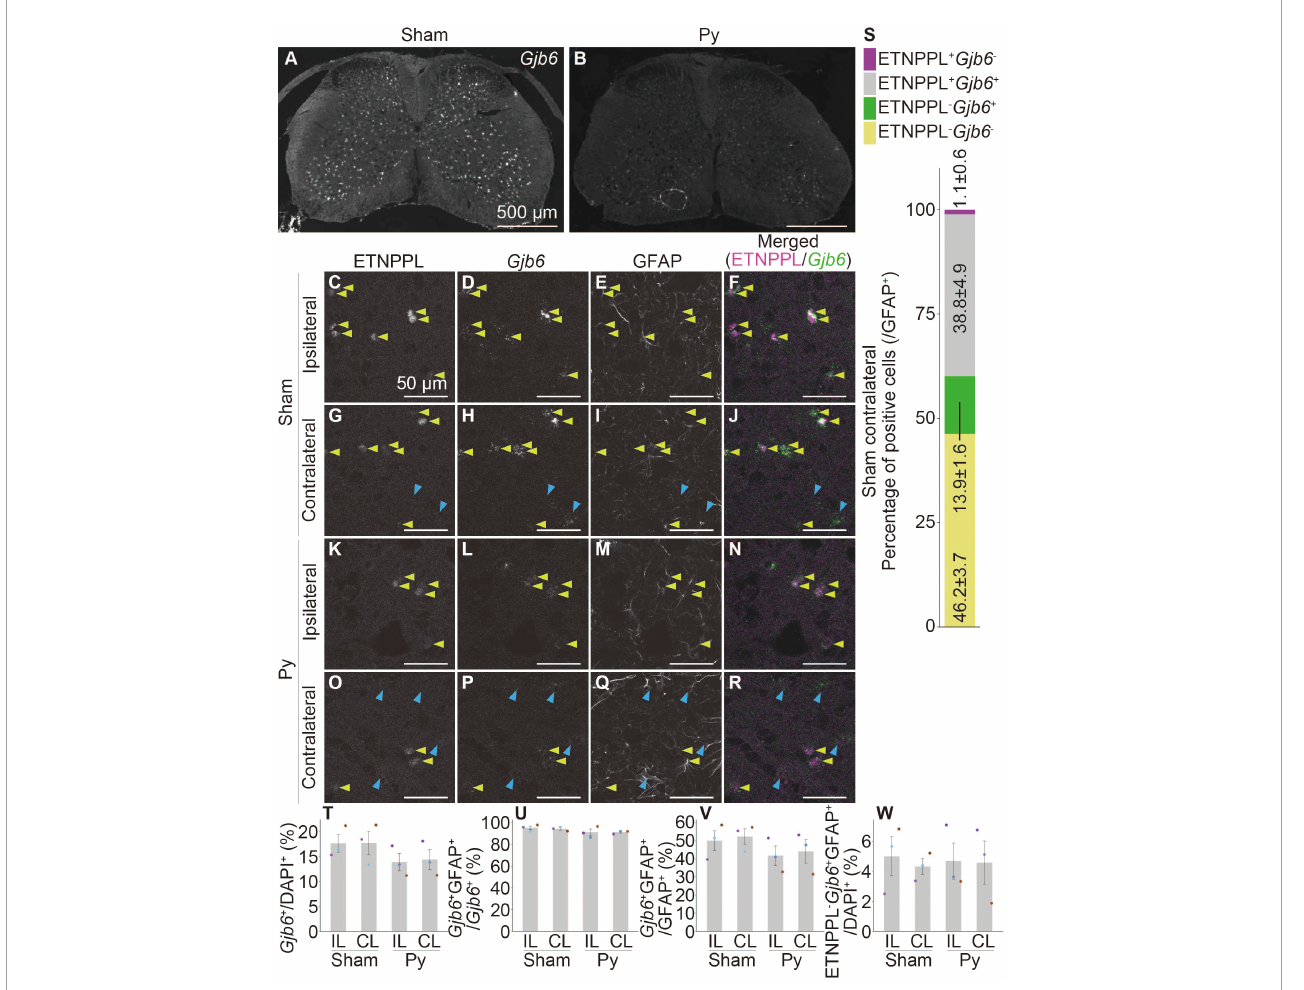
FIGURE10 Co-localization of ETNPPL and Gjb6 . (A,B) Representative images of the cervical cord of 8 W female mice 3 days after sham surgery (A) or pyramidotomy (B) stained for Gjb6 (RNAscope). Scale bars: 500 µ m. (C–R) Magnified confocal images of the gray matter of the ipsilateral (C–F,K–N) or contralateral side (G–J,O–R) of the sham (C–J) or pyramidotomy group (K–R) are shown. Signals for ETNPPL (C,G,K,O) , Gjb6 (D,H,L,P) , or retrieved GFAP (E,I,M,Q) are shown. In merged images (F,J,N,R) , magenta indicates ETNPPL and green indicates Gjb6 . Yellow arrowheads indicate the ETNPPL- Gjb6 -GFAP triple-positive cells. Blue arrowheads indicate the ETNPPL − Gjb6 + GFAP + cells. Scale bars: 50 µ m. (S) Percentage of each cell population among total GFAP + astrocytes on the contralateral side of the sham group. Magenta indicates ETNPPL + Gjb6 − cells, gray indicates ETNPPL + Gjb6 + cells, green indicates ETNPPL − Gjb6 + cells, and yellow indicates ETNPPL − Gjb6 − cells. (T–W) Quantification of changes in Gjb6 -expressing cells after pyramidotomy. The vertical axes represent the percentage of Gjb6 + cells to total cells (T) , Gjb6 + GFAP + cells to total Gjb6 + cells (U) , Gjb6 + GFAP + cells to total GFAP + astrocytes (V) , or ETNPPL − Gjb6 + GFAP + cells to total cells (W) . Mean ± S. E. M. n = 3 individuals, each of which is the average of four different sections. The same color indicates the same individual. IL, ipsilateral; CL,